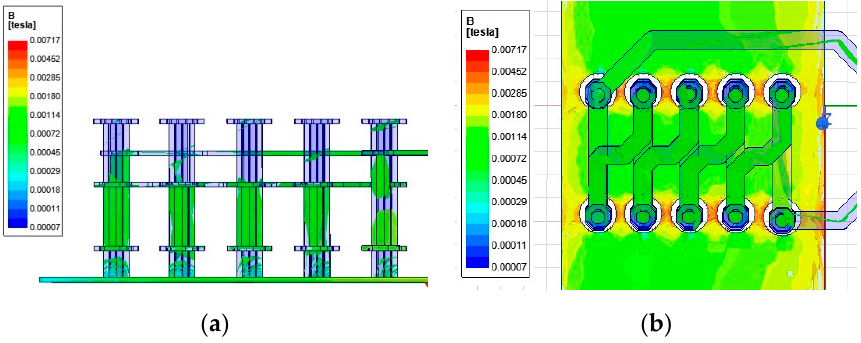
Figure 3. PCB circuit analysis using finite element method: ( a ) side view; ( b ) top view.